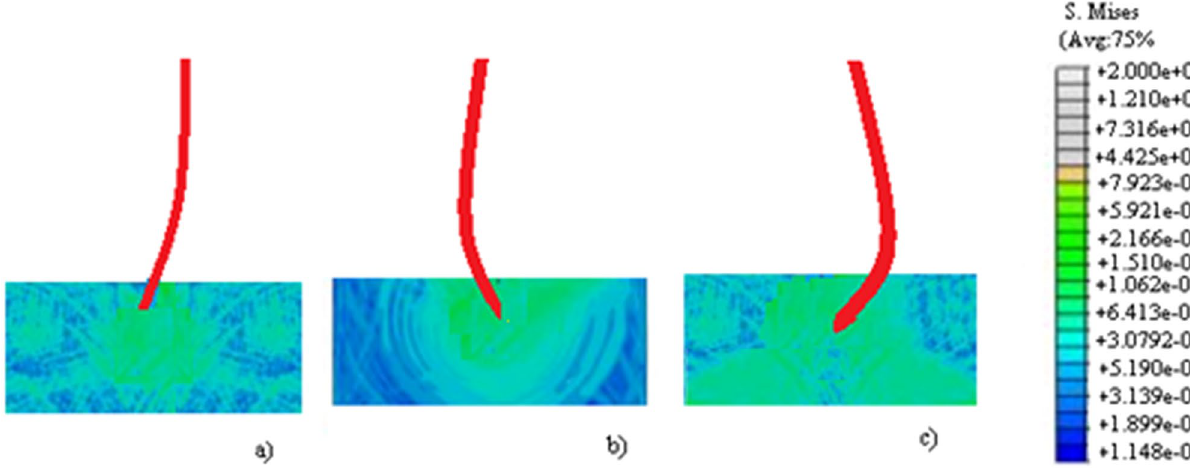
Figure 7. Insertion simulation results for different values of h and b ; ( a ) h = 0.5 and b = 0.15; ( b ) h = 0.55 and b = 0.2; ( c ) h = 0.6 and b =